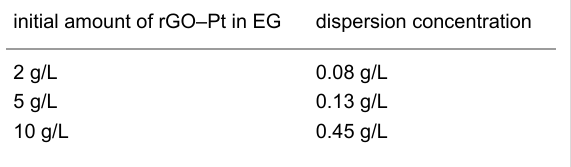
Table 1: Initial amount of rGO–Pt in EG and amount obtained in dispersion as estimated from absorbance at 660 nm. initial amount of rGO–Pt in